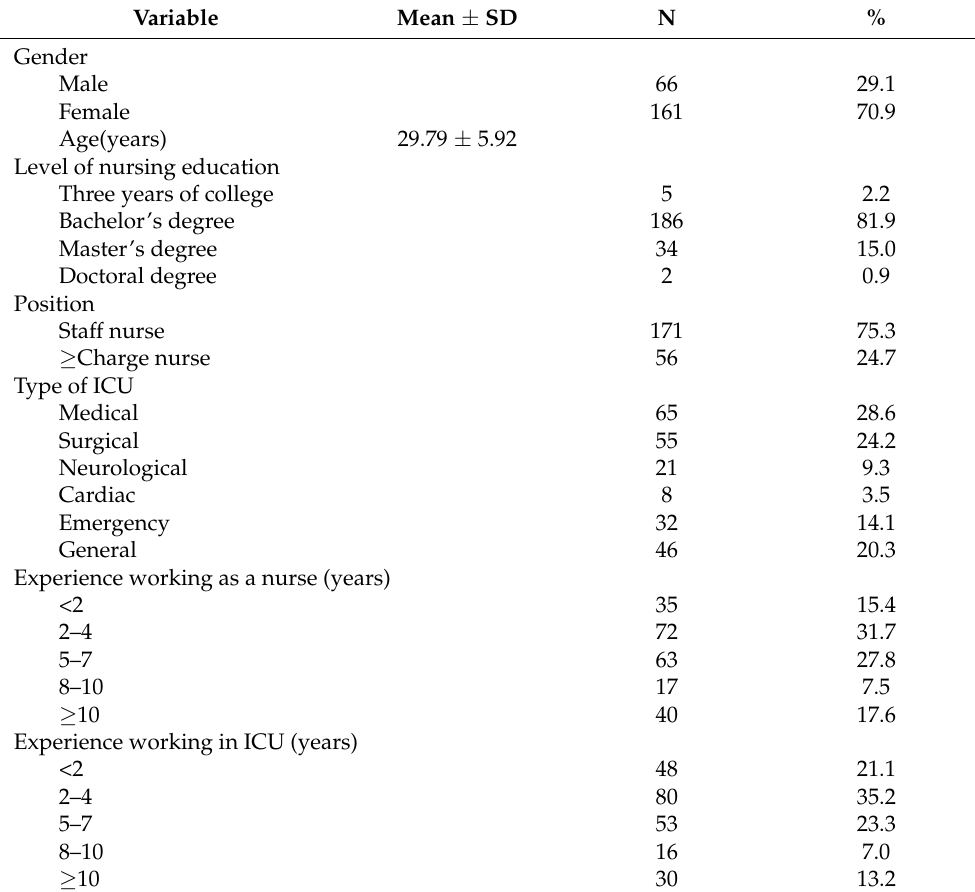
Table 1. General characteristics of participants (n =